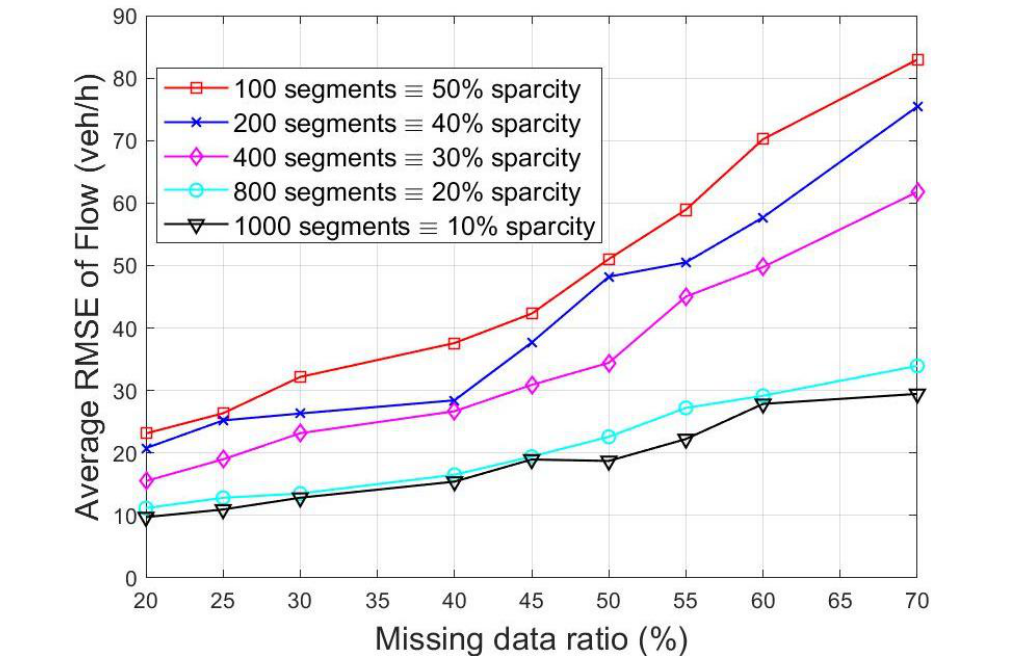
Figure 6. RMSE of flow at different missing data